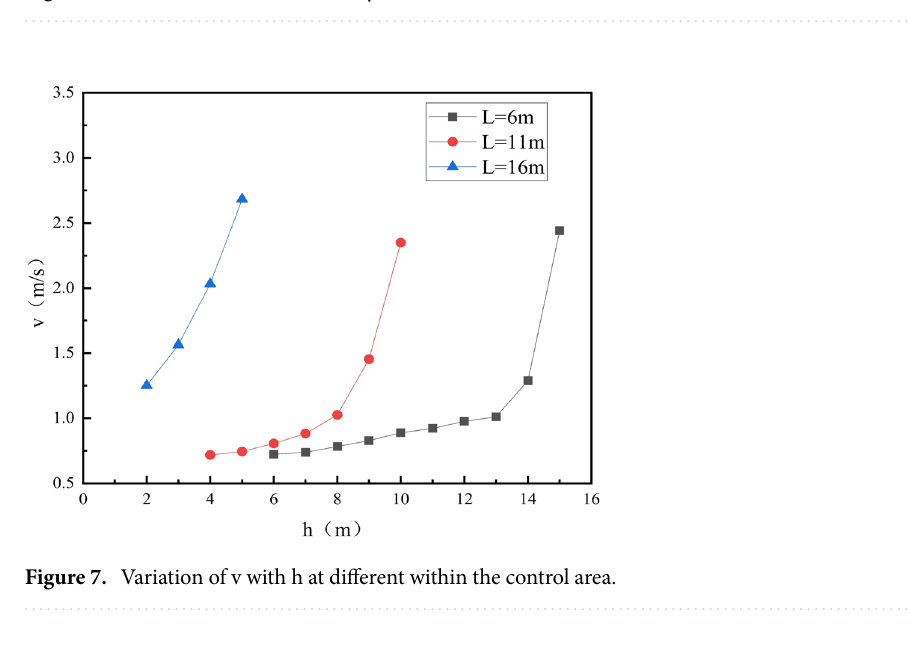
Figure 6. Simulation results of velocity field when L = 16 m.